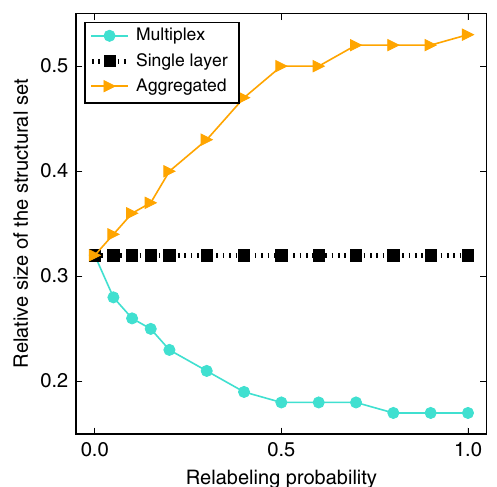
Fig. 3 Dependence of the size of the structural set on edge overlap and interlayer degree – degree correlation. We consider multiplex networks, in which, initially, both layers are a copy of a random network generated according to the Erd ő s − Rényi model with N = 1,000 nodes and average degree 〈 k 〉 = 5. Then, in one of the layers, each node is selected to switch its label with another randomly chosen node with a certain probability α . We determine, as a function of α , the mean value of the relative size of the